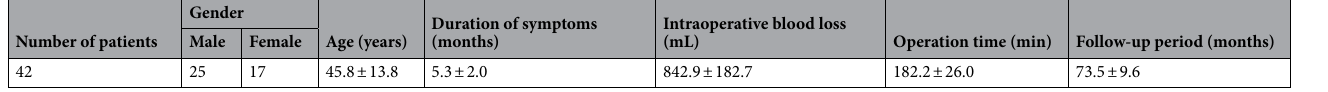
Table 1. Demographic, disease characteristic and operative information of patients (average ± standard